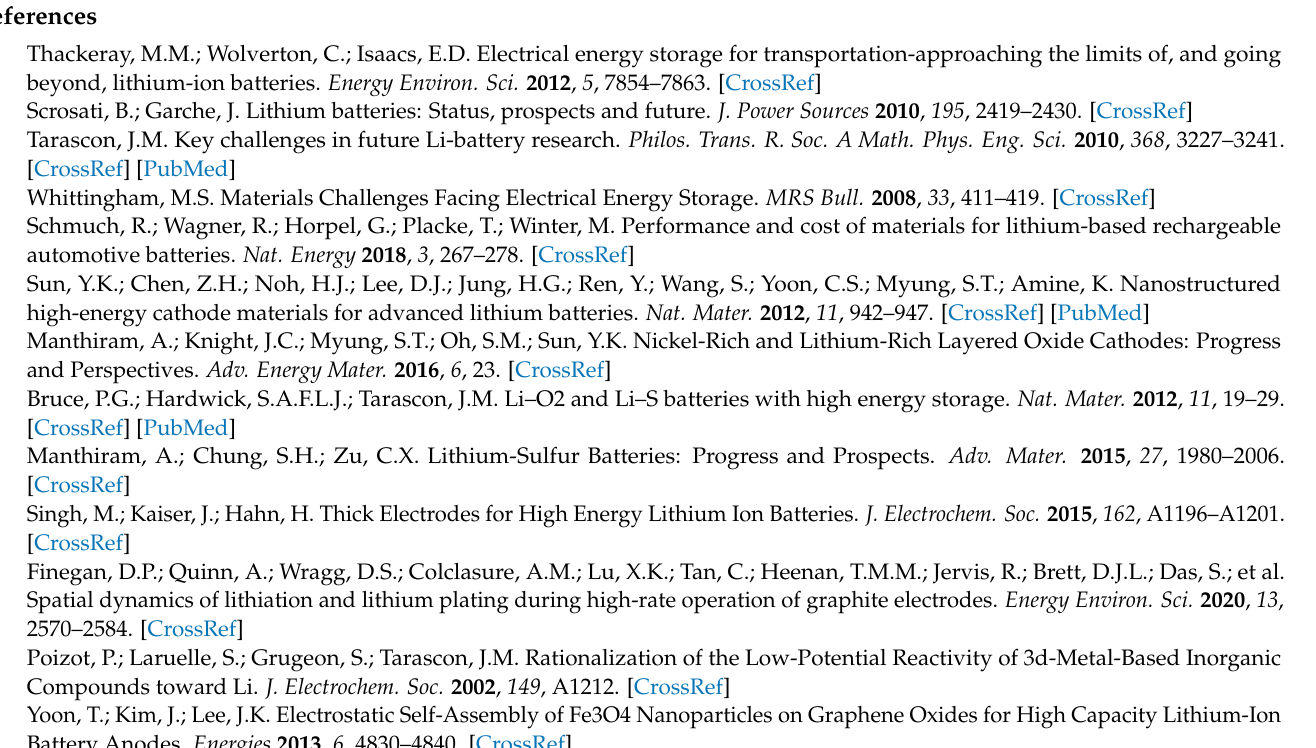
MMN/C2 after cycle. Figure S5: SEM images of electrode cross sections before and after lithiation, Figure S6: Charge and discharge voltage profiles of MMN for the first cycle without FEC (5%). Figure S7: (a) Rate responses and (b) charge and discharge voltage profiles of graphite. Figure S8: Cycling performances of MMN (cid:107) NCM523 full cells cycled with and without FEC. Figure S9: Voltage- capacity profiles of (a) Gr (cid:107) NCM523 and (b) MMN (cid:107) NCM523 full cells at various